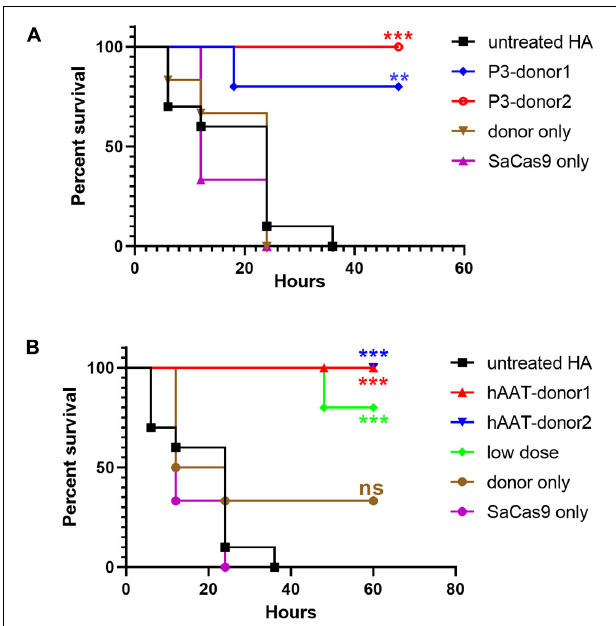
FIGURE 7 | Proportions of surviving mice after the tail-clip challenge. (A) Mice treated with donor vector using P3 promoter. Untreated HA, n = 10; P3-donor 1, n = 5; P3-donor 2, n = 5; donor only, n = 6; SaCas9 only, n = 6. (B) Mice treated with donor vectors using hAAT promoter. Untreated HA, n = 10; hAAT-donor 1, n = 5; hAAT-donor 2, n = 5; low dose, n = 5; donor only, n = 6; SaCas9 only, n = 6. Each experimental group was compared with the untreated group using the log-rank test. ∗∗ P < 0.01, ∗∗∗ P <